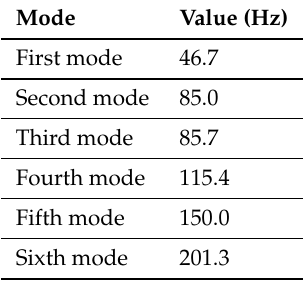
Table 3. Simulation results of the first-six resonant modes.